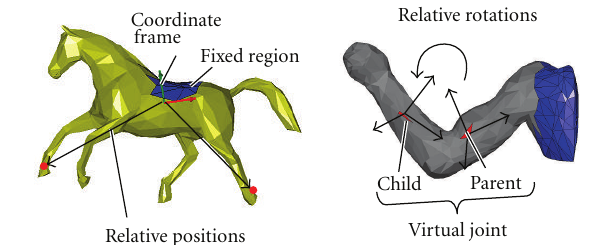
Figure 5: We infer a pose of a model from relative positions and rotations computed from handle